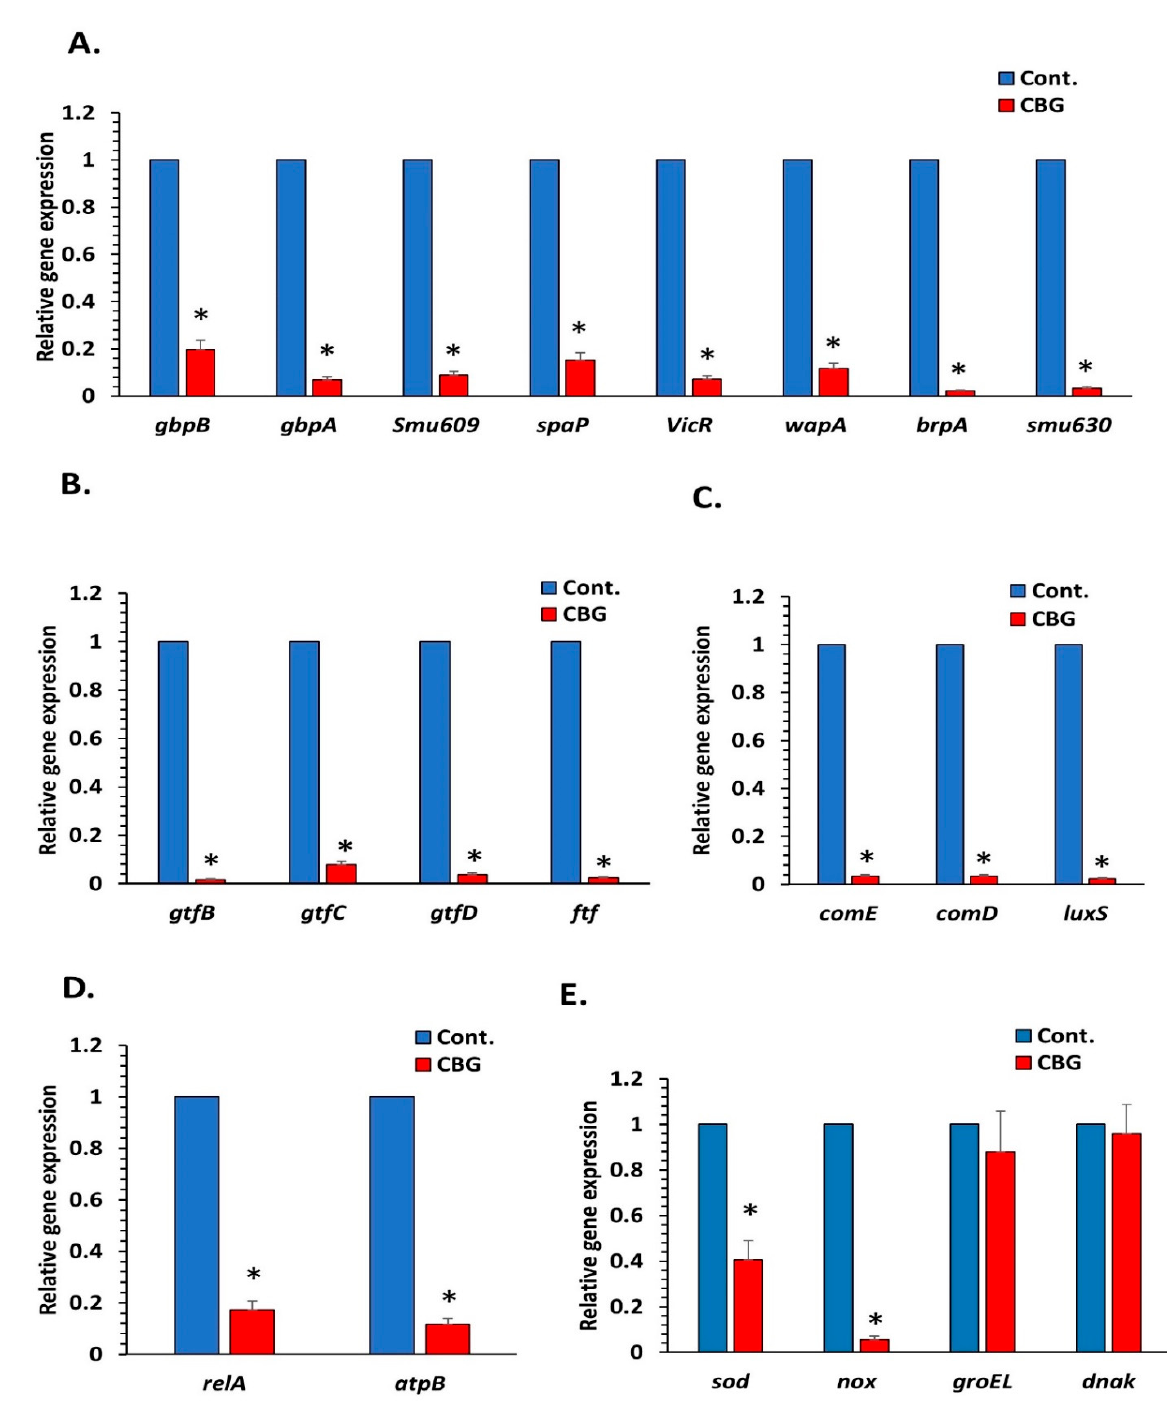
Figure 6. Effect of CBG on gene expression in S. mutans biofilm. Gene expression in CBG-treated S. mutans biofilm (2.5 μ g/mL, 24 h) in comparison with untreated control as quantified by real-time PCR using respective primers. ( A ). Biofilm formation-related genes. ( B ). EPS formation-related genes. ( C ). Quorum sensing-related genes ( D ). Acid tolerance-related genes. ( E ). Antioxidant and stress responsive-related genes. n = 3. * p < 0.05.